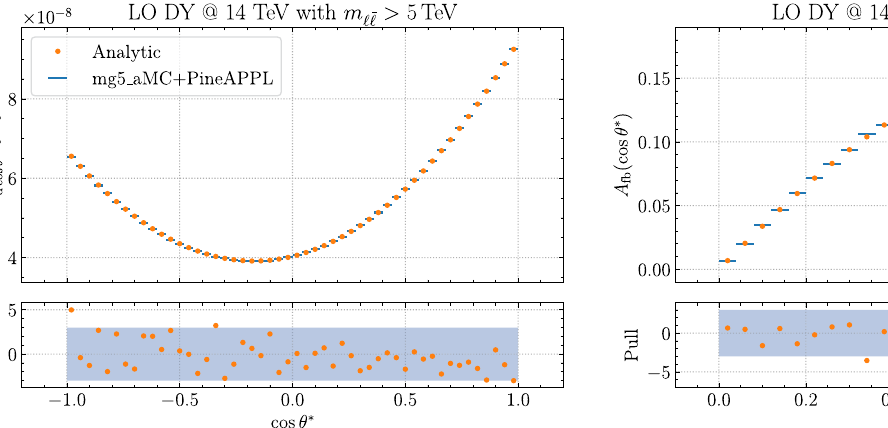
Fig. 3 The single-inclusive differential distribution in the Collins– Soper angle cos θ ∗ , Eq. (2.17), and the corresponding forward– backward asymmetry computed at LO, where the analytic calculation Eq. (2.22) is compared with the numerical simulation based on Mad- Graph5_aMC@NLO interfaced to PineAPPL . The bottom panels dis-